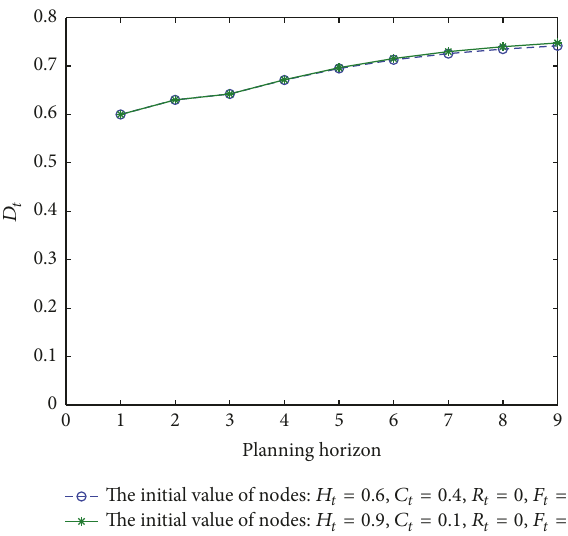
Figure 2: The value of 𝐷 𝑡 for several planning